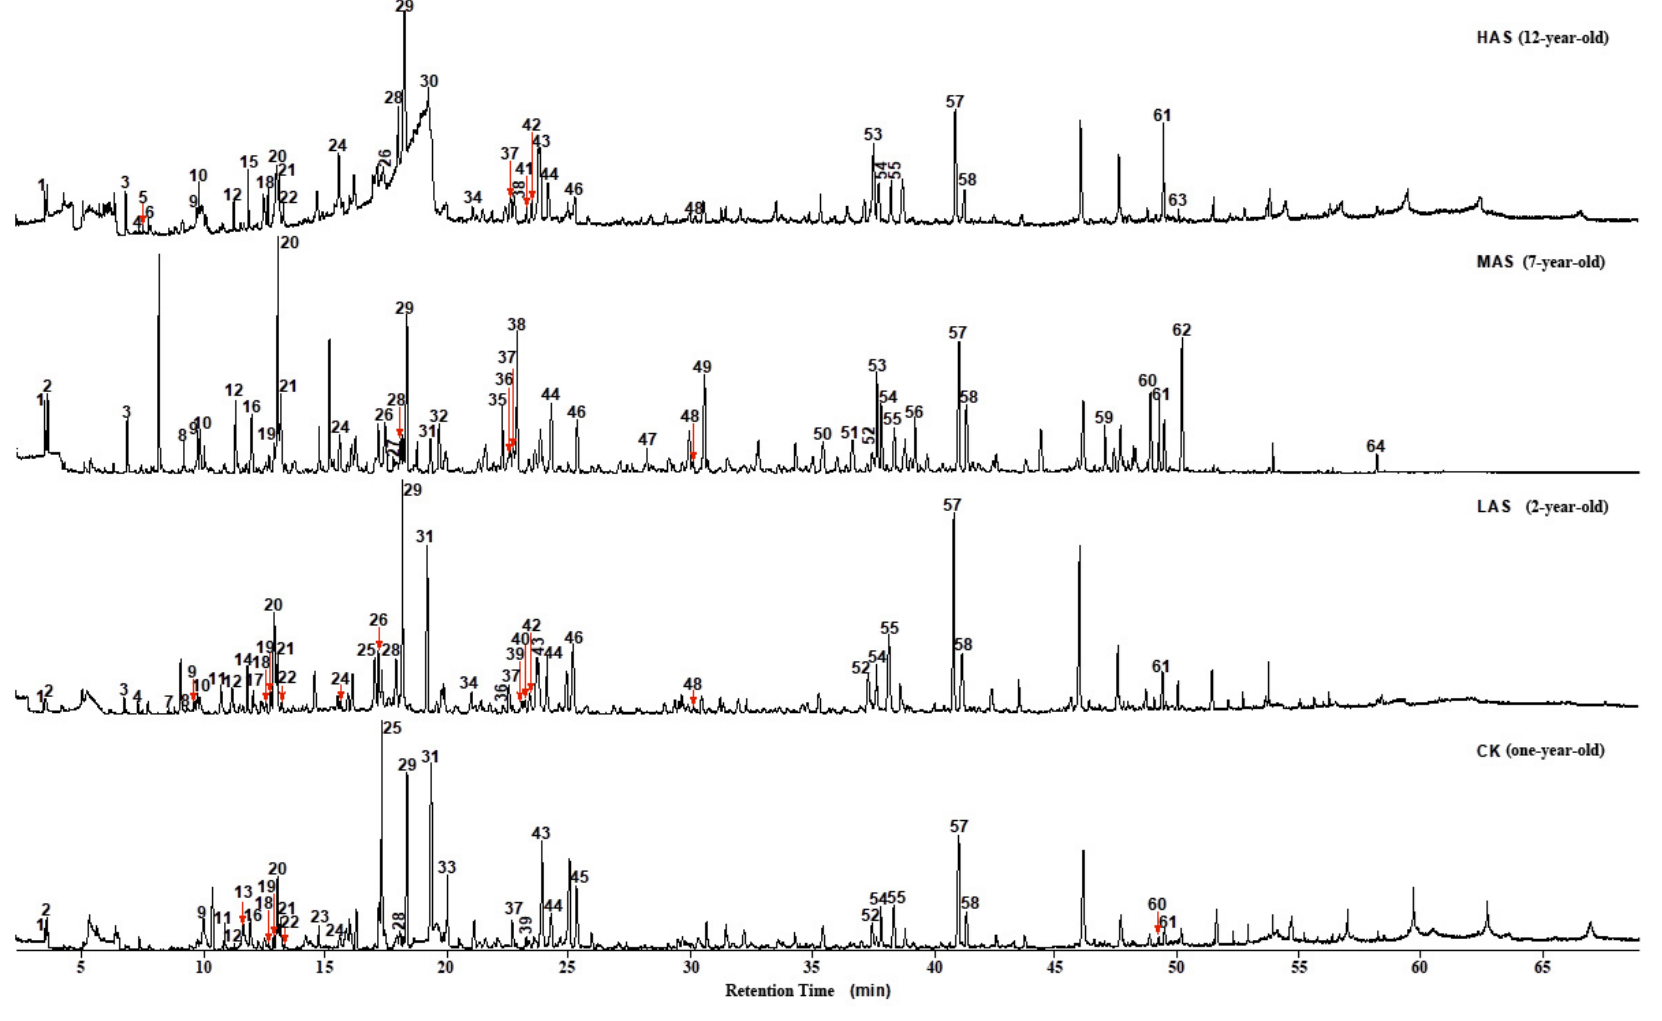
Figure 1. Total ion chromatogram of four An–tea samples. Figure 2. Total ion chromatogram of four An–tea